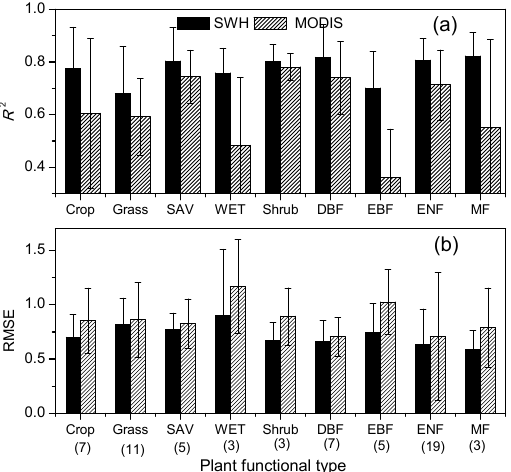
Figure 3. Mean difference between the model predictions (including the SWH model and the MODIS ET algorithm) and observations in terms of ( a ) the determinant coefficient of the model-observation relationship ( R 2 ); and ( b ) the root mean square error (RMSE) for each plant functional type. The numbers in parentheses indicate the number of sites used in this study. The error bars indicate standard deviations.